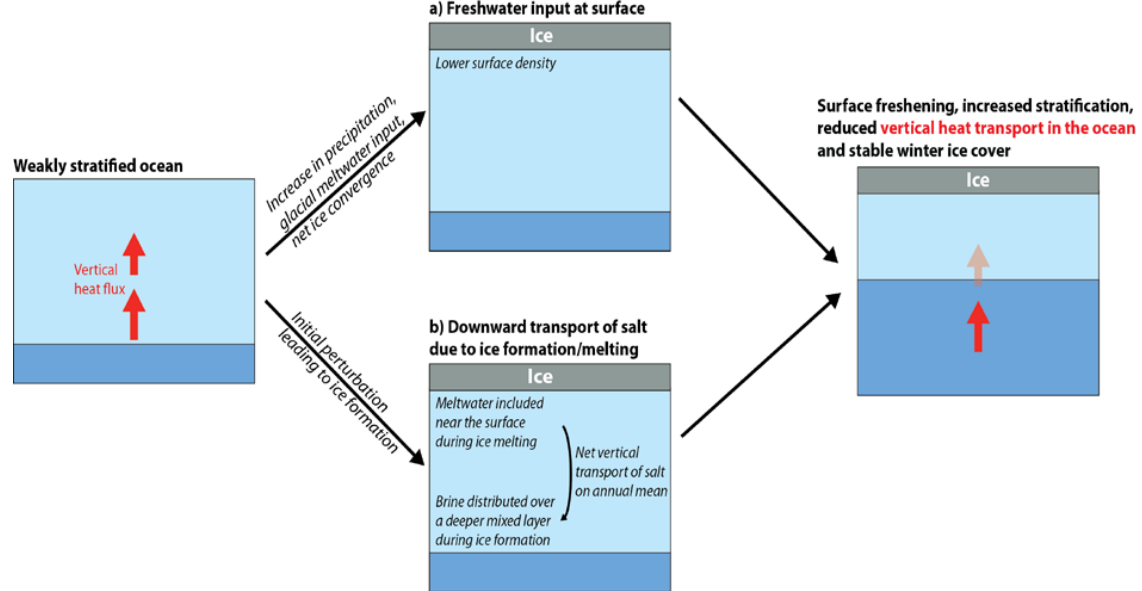
Fig. 3. Schematic representation of the stabilization of the Southern Ocean by sea ice processes. to the mixed layer deepening. Consequently, the salt input is distributed over a relatively large depth. If the mixed layer depth was constant during the whole year and in the absence of sea ice transport, the sea ice melting in summer will per- fectly compensate for this brine release and no net effect on the ocean salinity would be observed in the annual